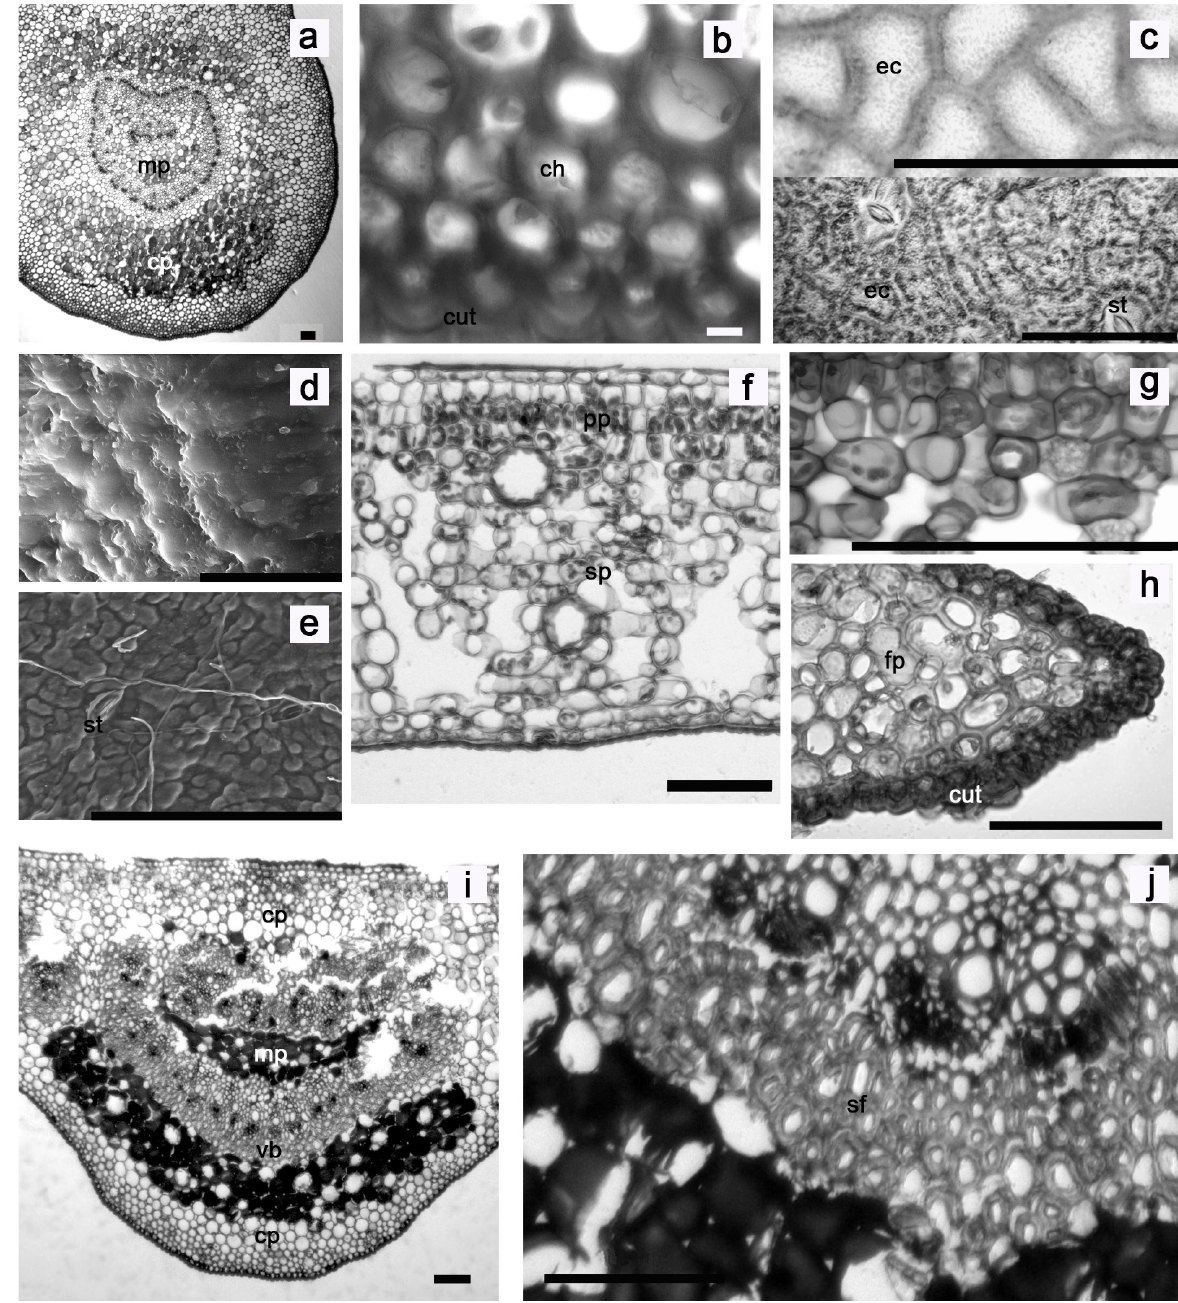
Figure 1 - Leaf anatomy of C. criuva . a : Overview of the petiole cross-sectional; b : Abaxial face of the epidermis, showing the cuticular flanges and the collenchyma ring; c : Adaxial and abaxial face of the epidermis, showing paracytic stomata; d : Detail of cuticle in adaxial surface of the epidermis in scanning electron microscopy; e : Detail of cuticle on the abaxial surface of the epidermis in scanning electron microscopy; f : Overview of the mesophyll; g : Intermediate layer showing elongated cells and intercellular spaces; h : Detail of edge of leaf, showing the cuticular flanges and impregnation of internal periclinal wall; i : Overview of the midrib; j : Details of vascular bundles of the midrib. mp: Medullary parenchyma; cp: Cortical parenchyma; ch: Collenchyma; cut: Cuticle; ec: Epidermal cells; st: Stomata; pp: Palisade parenchyma; sp: Spongy parenchyma; fp: Fundamental parenchyma; vb: Vascular bundles; sf: Sclerenchyma fibers. Scale bar = 100 µm, except in Fig. 1 d (Scale bar = 5